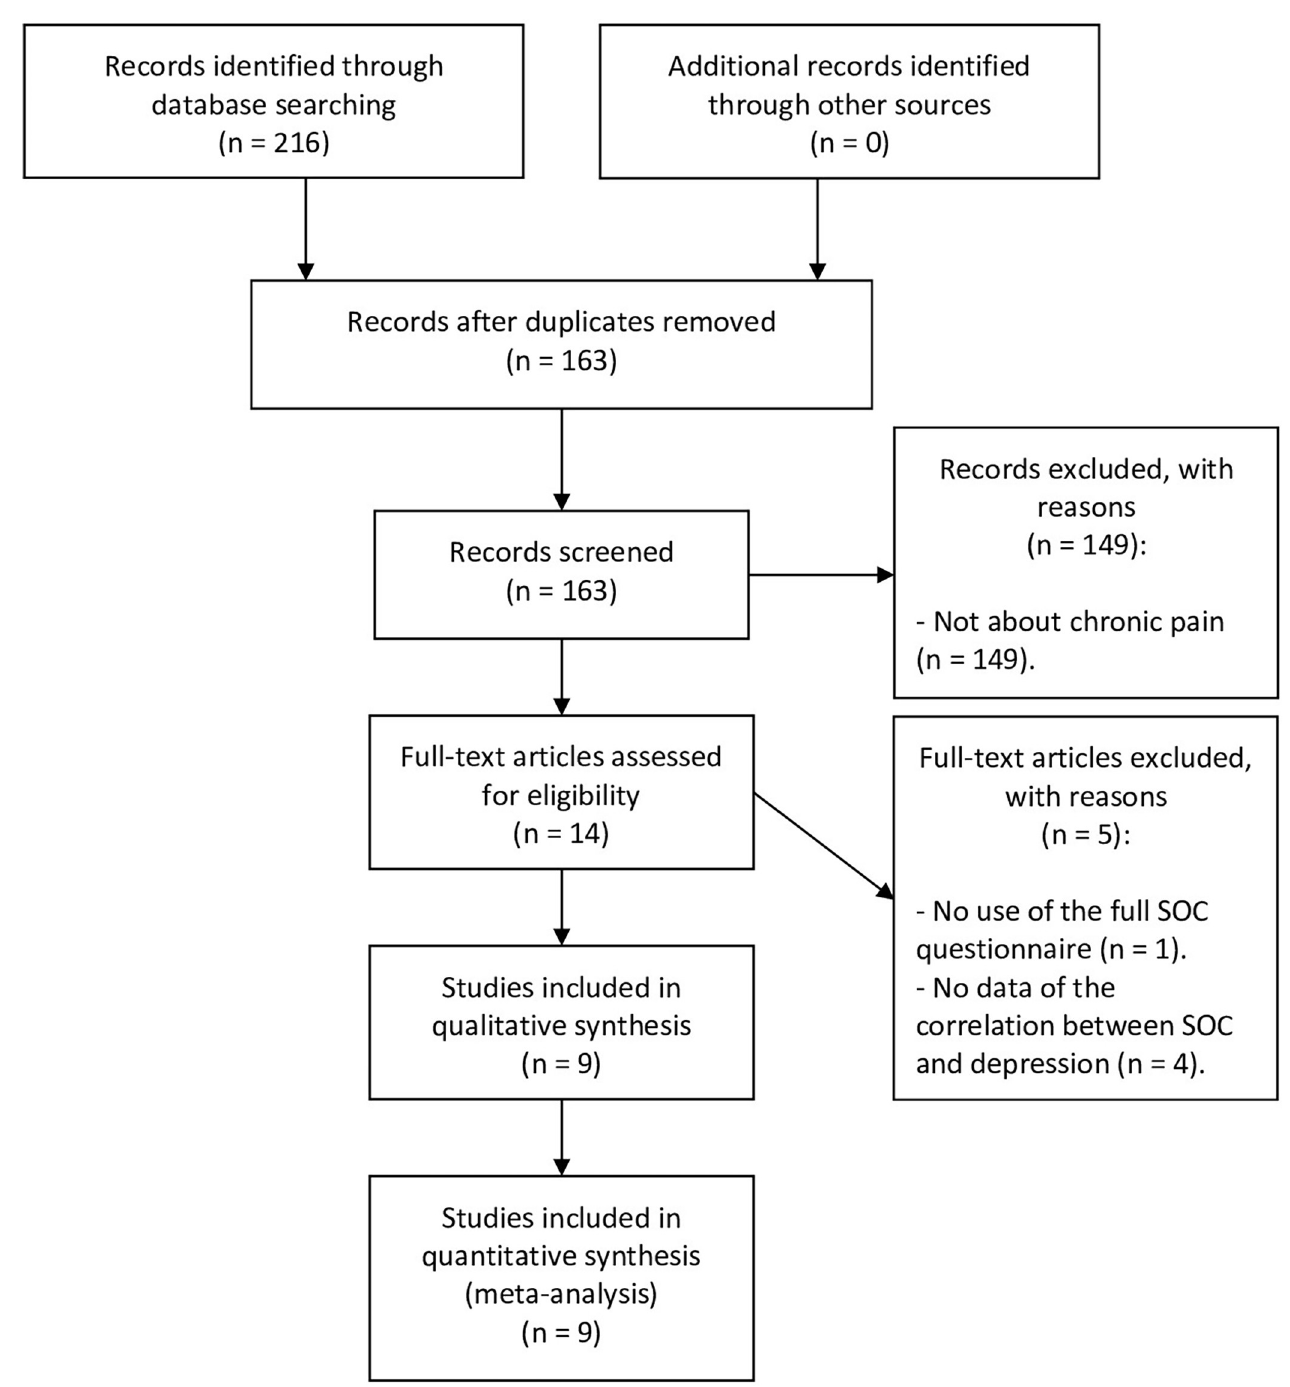
Fig 1. Flow diagram for articles identified, screened eligible, and included in this